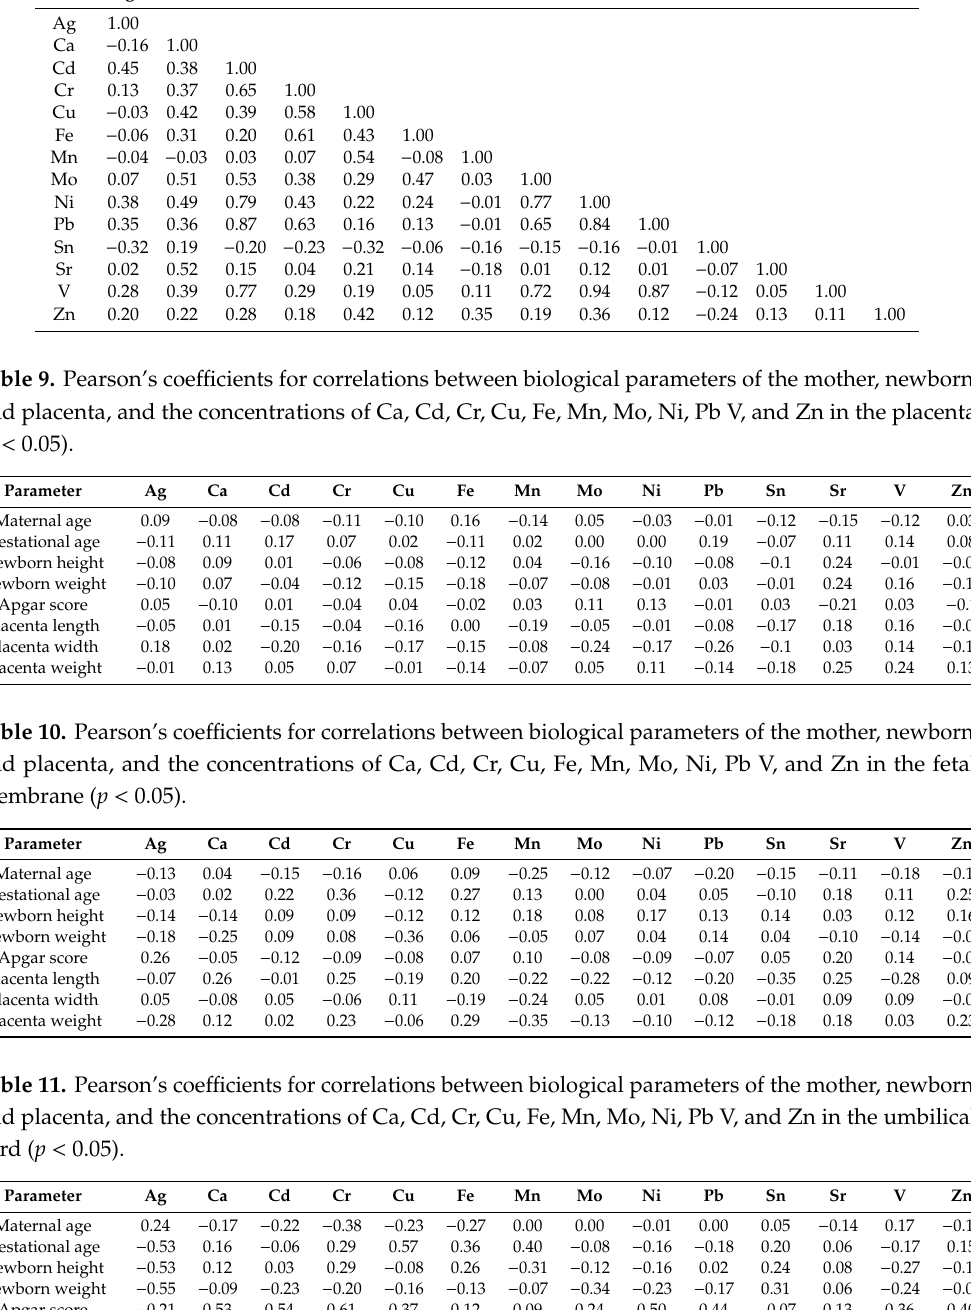
Table 8. Pearson’s correlation coe ffi cients for metals found in the umbilical cord ( p < 0.05). Ag Ca Cd Cr Cu Fe Mn Mo